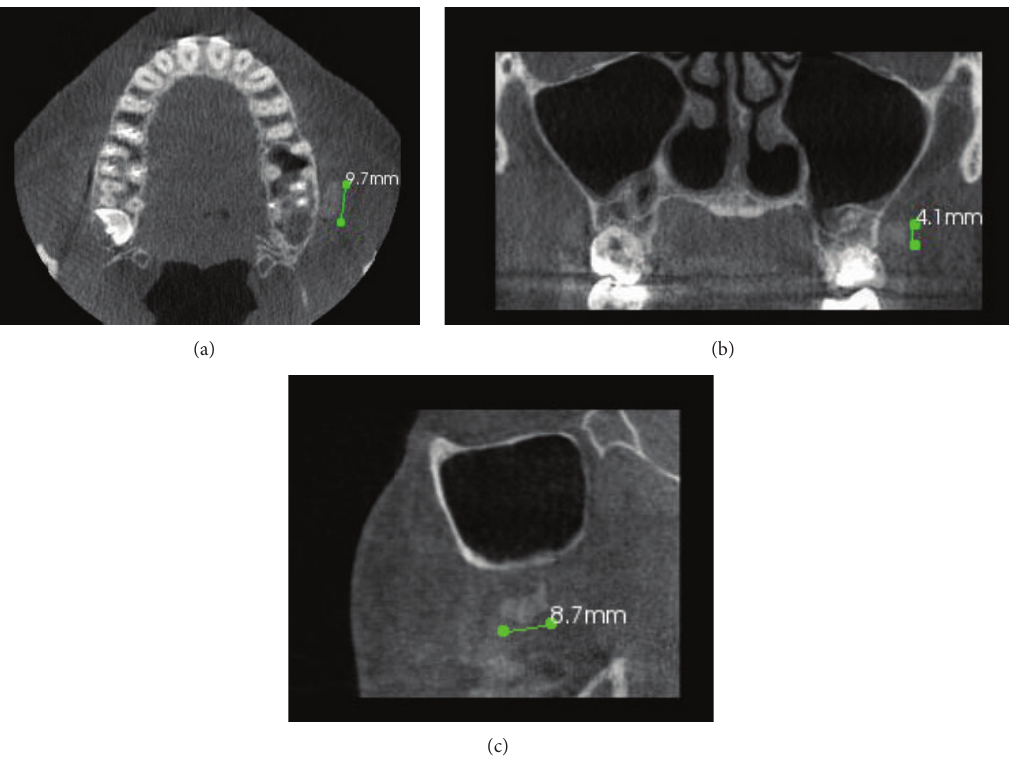
Figure 4: (a) CBCT axial cuts showing the extent of the radio-opacity of the lesion in the vestibular side and then in relationship with the second molar. (b) and (c) Coronal and sagittal CBCT scan image demonstrating also the radio-opacity at the same level of the coronal 1/3 of the root canal. The lesion measured approximately 9.7 × 8.7 ×